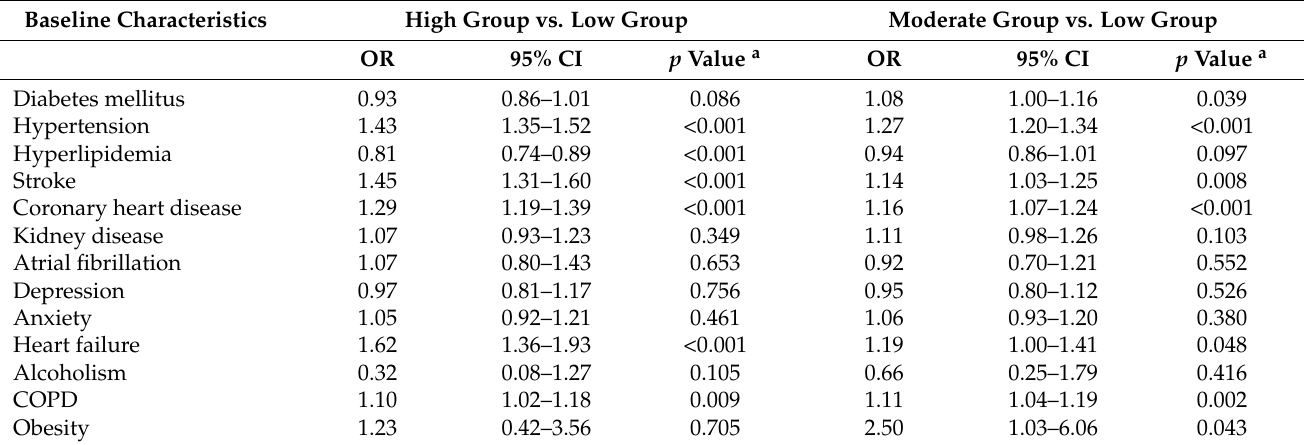
Table 2. Baseline characteristics associated with dementia trajectory groups.